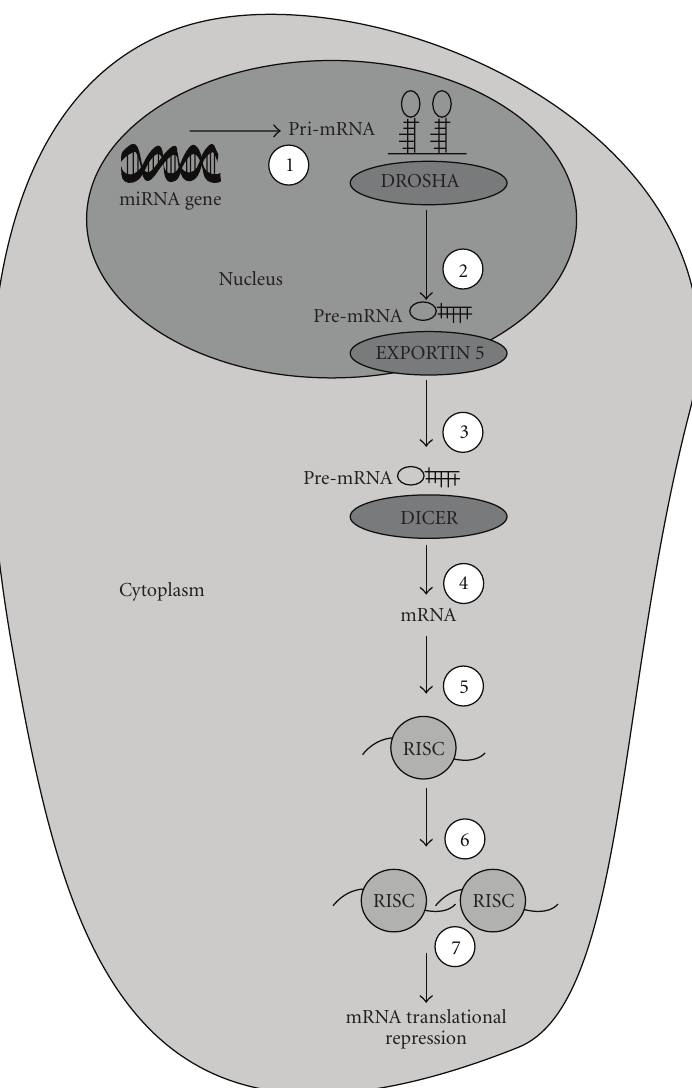
Figure 4: The miR Pathway. Step 1 of the miR pathway involves the transcription of a 70–100 nucleotide (nt) pri-miR from an miR gene which is then processed in the nucleus via Step 2 by the RNAse III enzyme, DROSHA to yield pre-miR. Following the transport of pre-miR from the nucleus to the cytoplasm mediated by the nuclear export receptor protein, EXPORTIN 5 at Step 3, a second RNAse III enzyme, DICER, digests pre-miR at Step 4 resulting in a 21–25 nt miR. At this juncture, miR has the capacity to bind to the RNA-Induced Silencing Complex (RISC) and at Steps 5 and 6 aligns itself with an mRNA. The final step (Step 7) is dependent on whatever complimentarity exists between a miR and a target sequence in mRNA. Therefore, the degree of complimentarity between a miR and an mRNA results in either translational repression or mRNA cleavage (reviewed in